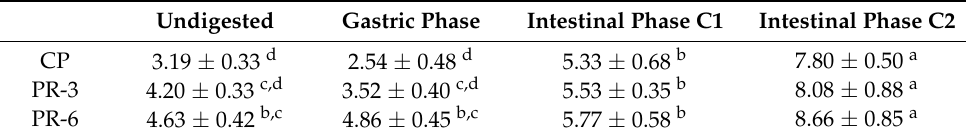
Table 5. Lipid oxidation ( µ moles MDA/Kg p â t é ) of the undigested and digested pork liver p â t é